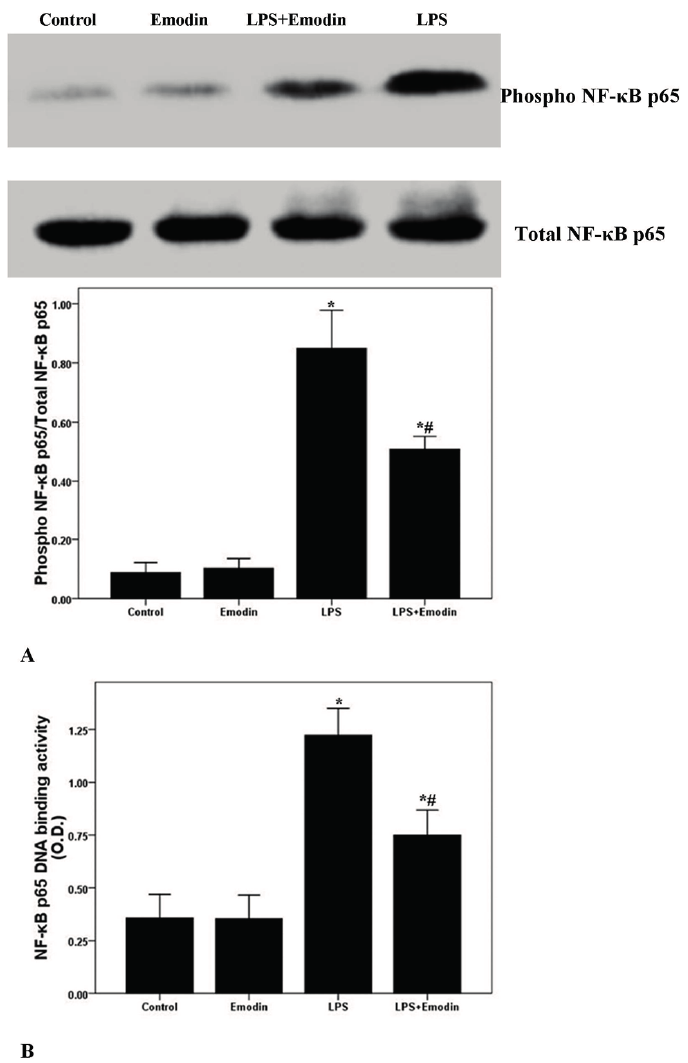
Figure 5. Emodin inhibits the phosphorylation and DNA binding activity of NF- κ B p65 in LPS-induced ALI. After 72 h interventions, mice were exsanguinated and their lungs were removed. ( A ) Western blotting was used to analyze the phosphorylation of NF- κ B p65 in lung; ( B ) DNA binding activity of NF- κ B p65 was measured by a TranAM™ p65 transcription factor ELISA kit. Each bar represents the mean ± SD of 10 mice. * p < 0.05 compared with Control. # p < 0.05 compared with